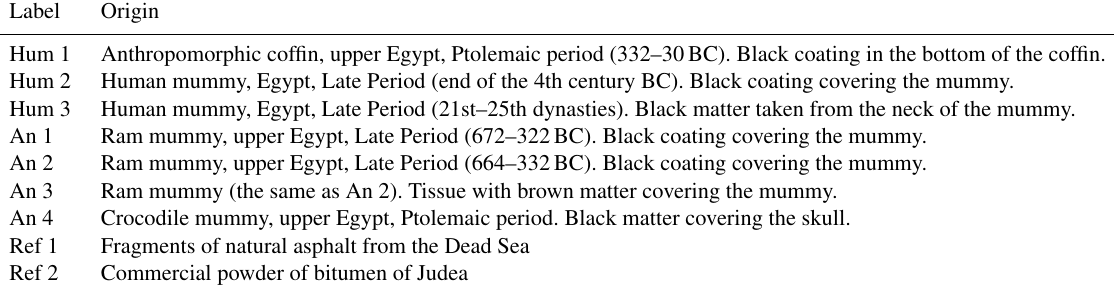
Table 1. Origins of the samples of black matter.